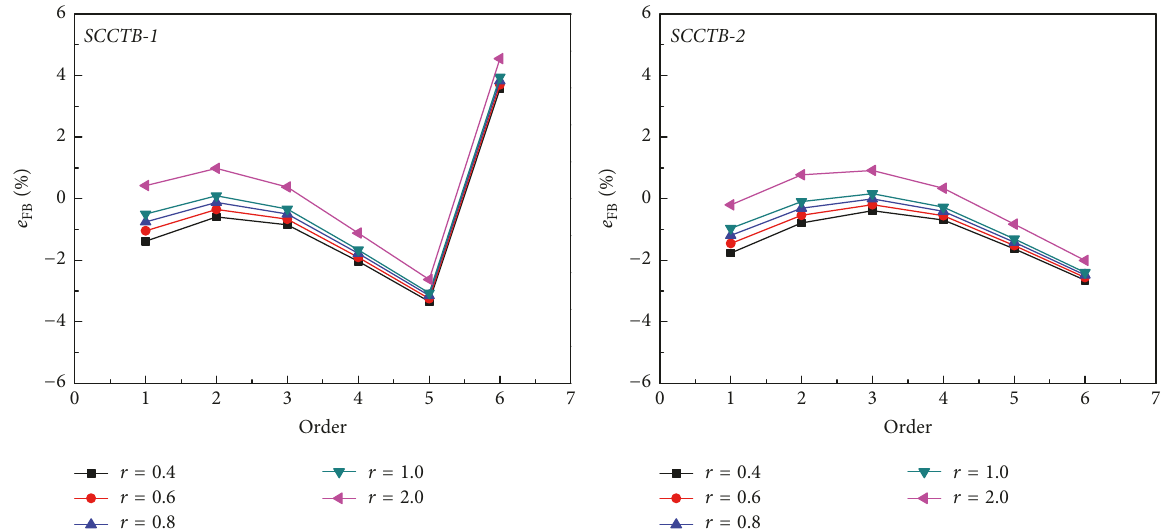
Figure 3: Relationship between the calculation errors of FBEM and the mode orders of natural vibration frequency.